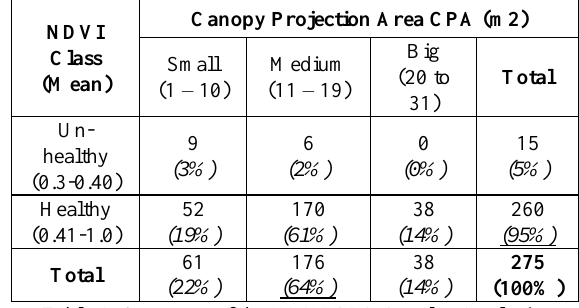
Table 1. Summary of the NDVI CPA Overlay Analysis